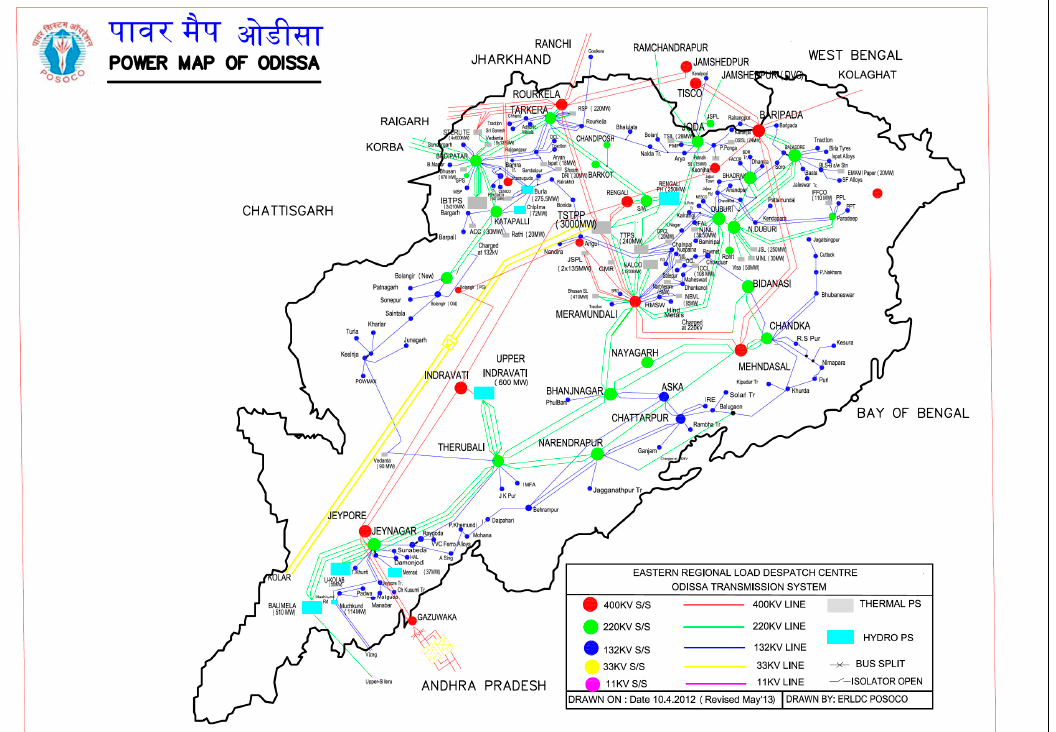
Figure 2. Power distribution system of Odisha.